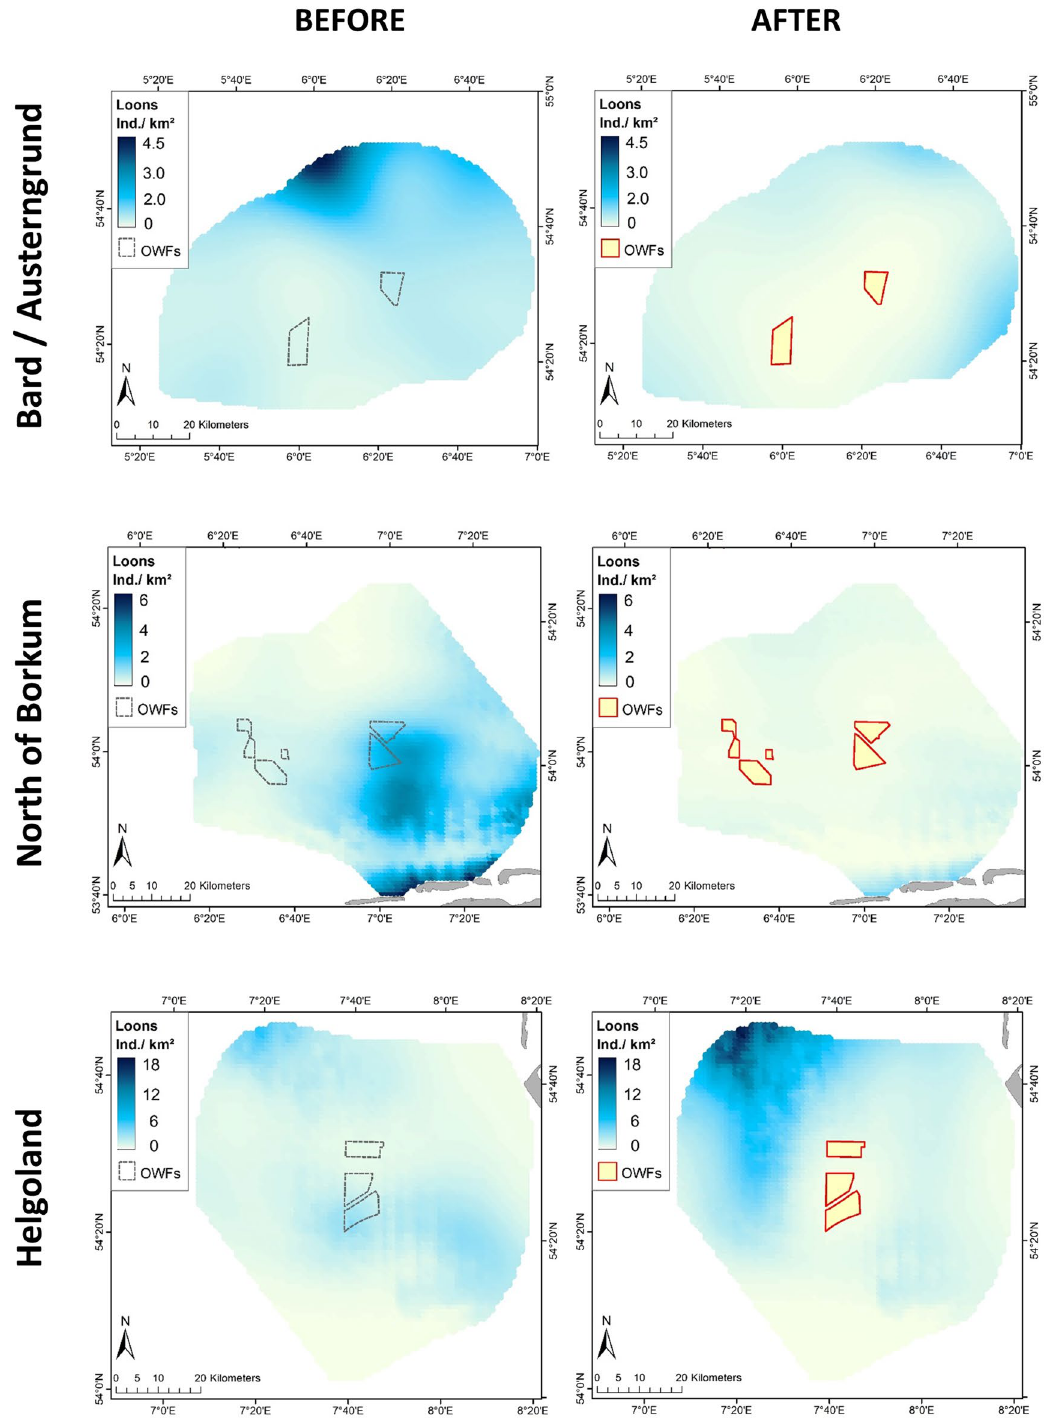
Figure 2. Modelled distributions of loons (individuals per km 2 ) before (left panels) and after (right panels) construction of wind farms, shown separately for each wind farm cluster. Note that abundance levels differ between clusters. The map was generated in ArcGIS 10.3 for Desktop, https:// www. esri. regularly productive transition zone between lower saline waters near the coast and more-saline waters offshore (ref. 35 ; for a hydrographic description see ref. 36 ). However, recent telemetry data from our study area showed that some individuals preferred more coastal waters with lower salinity, while others preferred offshore areas with higher salinity, potentially reflecting individual foraging-site fidelity 25 . When foraging for their highly mobile prey, loons are now more restricted in terms of their larger-scale movements because their former foraging area has been split into smaller units by the establishment of several OWFs.